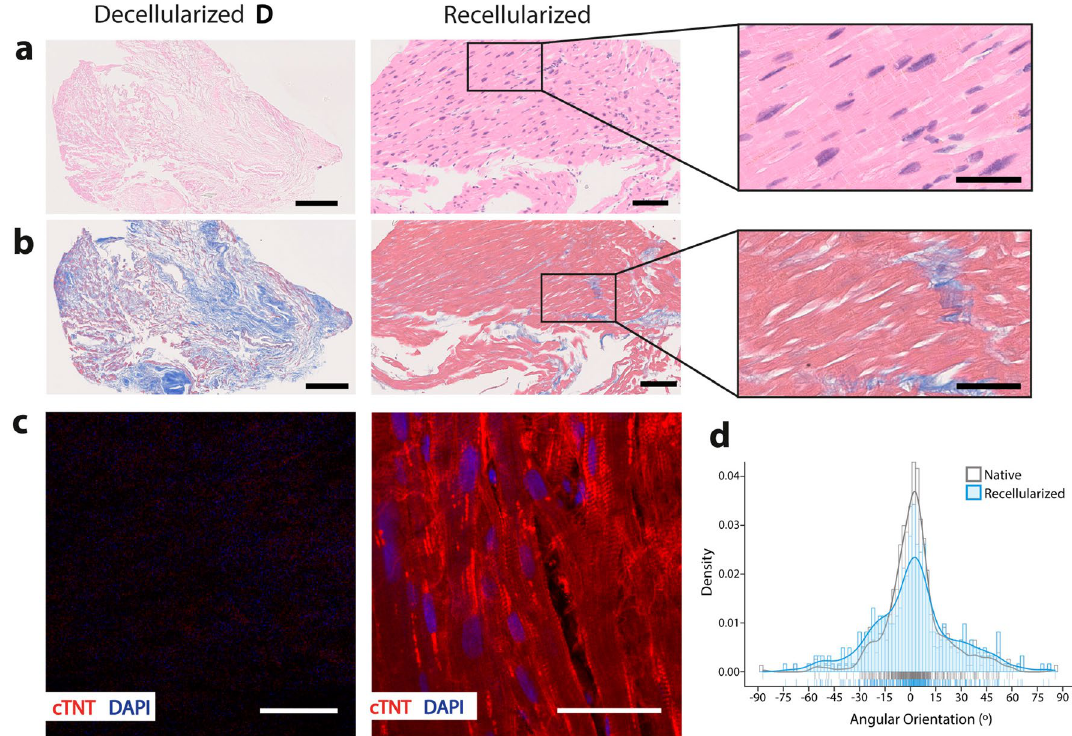
Figure 4. Assessment of tissue formation capacity of human induced pluripotent stem cell-derived cardiomyocytes (hiPSC-CM) on decellularized human cardiac tissue. ( a ) Hematoxylin & Eosin and ( b ) Masson’s Trichome staining of decellularized (method D) and recellularized tissue after 14 days of culture, at low (scale bars: 100 µm) and high magnification (scale bars: 50 µm). ( c ) Immunofluorescence micrograph of cardiac troponin T (cTNT, red) expression in decellularized tissue and recellularized tissue after 14 days of culture, and counterstained with DAPI (blue). Scale bar: 50 µm. ( d ) Density histogram of mean angular orientation of ventricular cardiomyocytes in native cardiac tissue and hiPSC-CM in recellularized tissue ( n > 300 ROI analyzed per